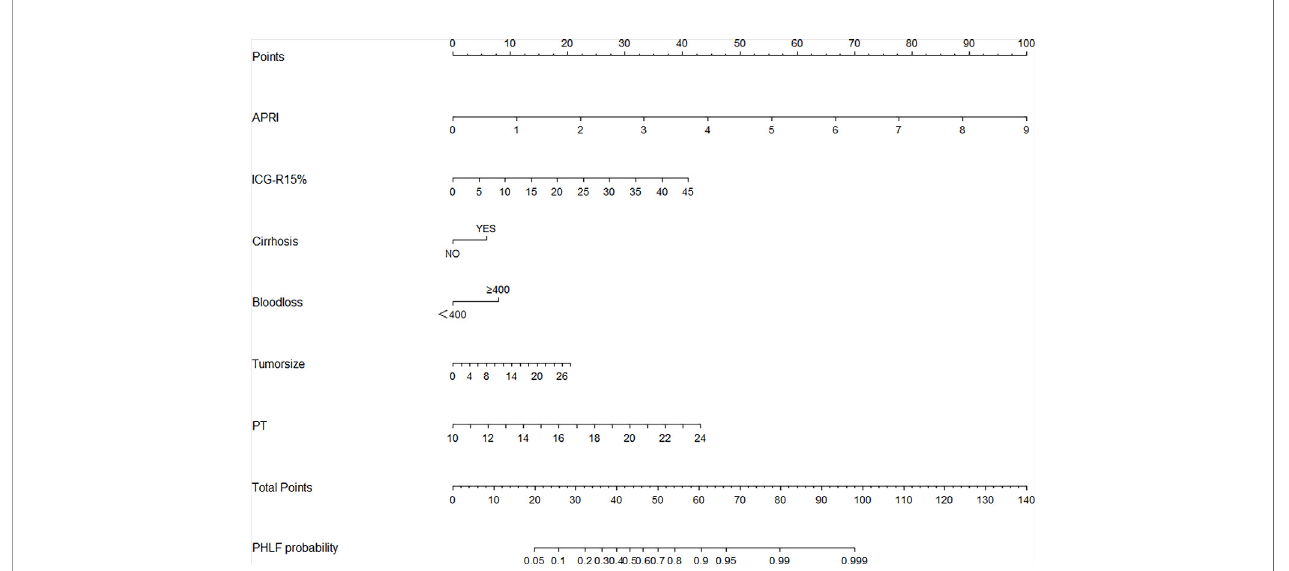
FIGURE 1 | The nomogram was developed in the training cohort and incorporated the AST-to-platelet ratio index (APRI), ICG-R15, tumor size, blood loss, cirrhosis, and prothrombin time (PT). To use the nomogram, an individual patient ’ s value is located on each variable axis, and a line is drawn upward to determine the number of points received for each variable value. The sum of these points is located on the total points axis, and a line is drawn downward to the likelihood of PHLF.